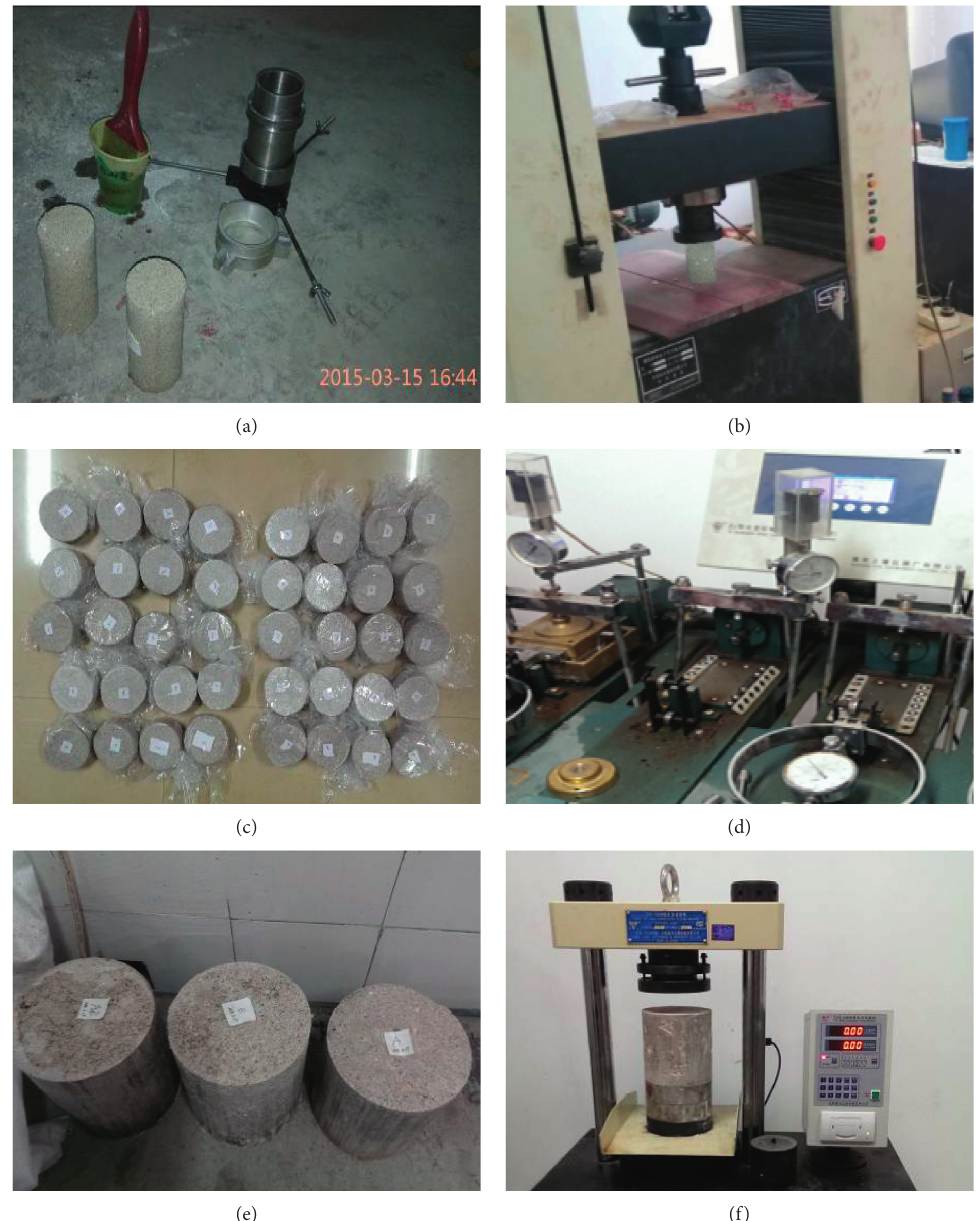
Figure 2: Parameter tests of similarity material for surrounding rock. (a) Elastic modulus test specimen. (b) Elastic modulus test. (c) Direct shear test specimens. (d) Direct shear test. (e) UCS test specimen. (f) UCS test.